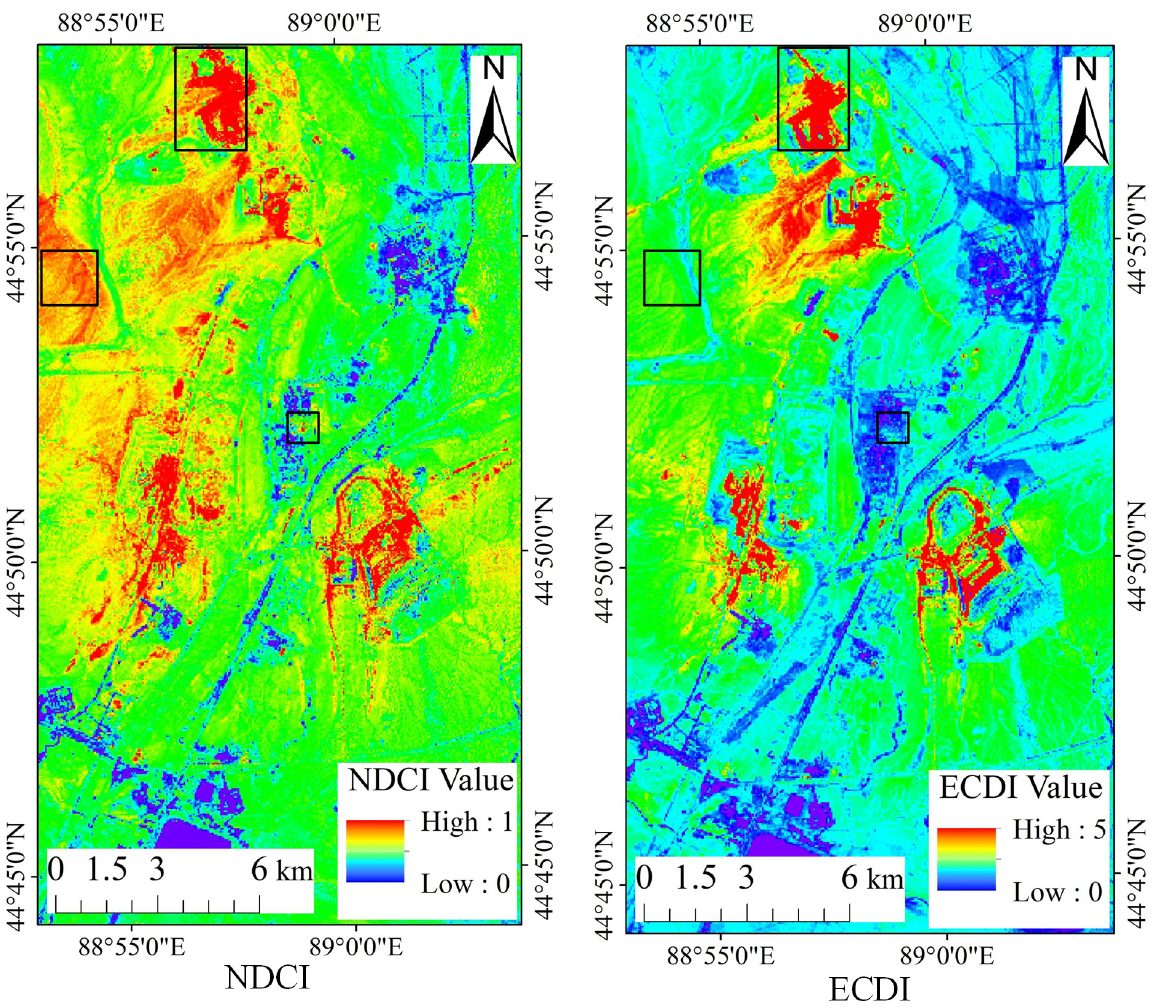
Fig 2. Comparison of the NDCI and ECDI